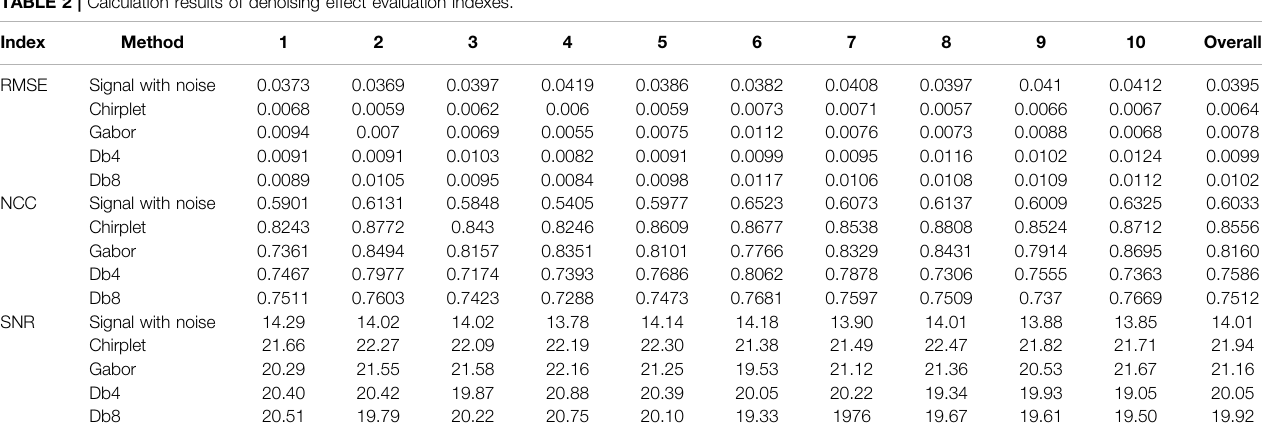
TABLE 2 | Calculation results of denoising effect evaluation